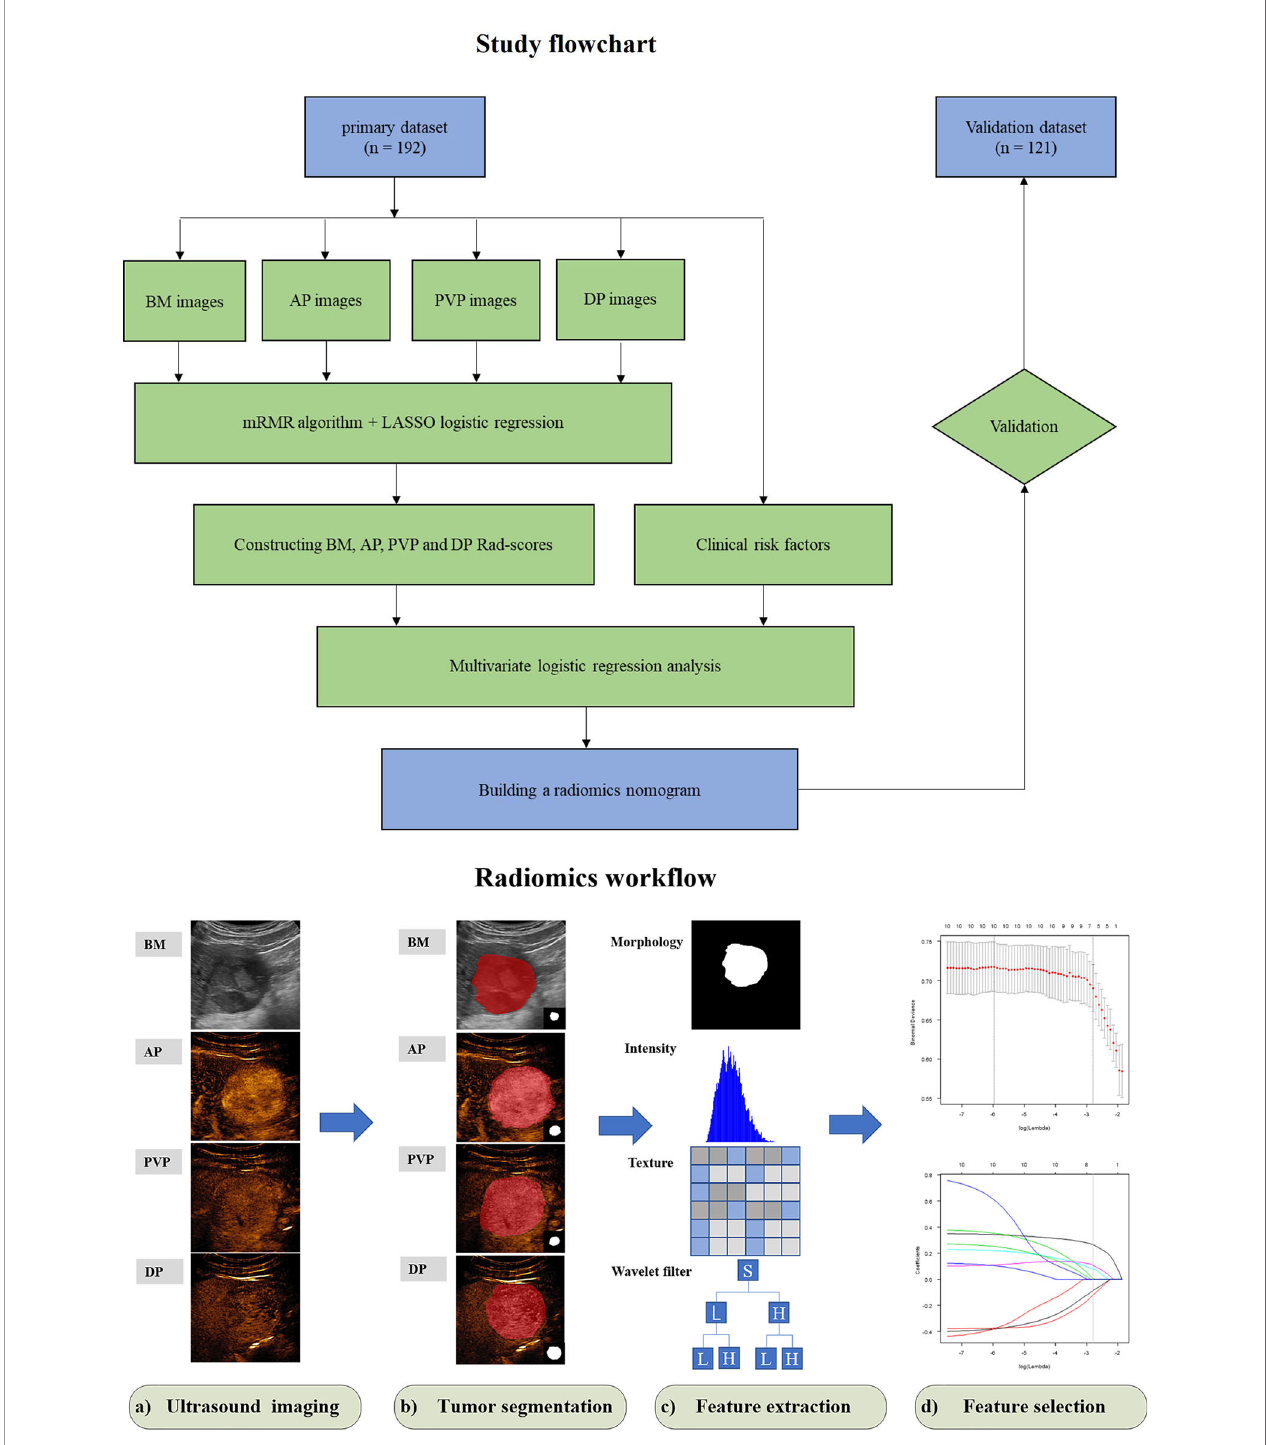
FIGURE 1 | Study fl owchart of radiomics nomogram modeling for the MVI status prediction in patients with HCC and radiomics work fl ow. BM, B-mode; AP, arterial phase; PVP, portal venous phase; DP, delay phase; Rad-score, radiomics score; mRMR, minimum redundancy maximum relevance; LASSO, least absolute shrinkage and selection